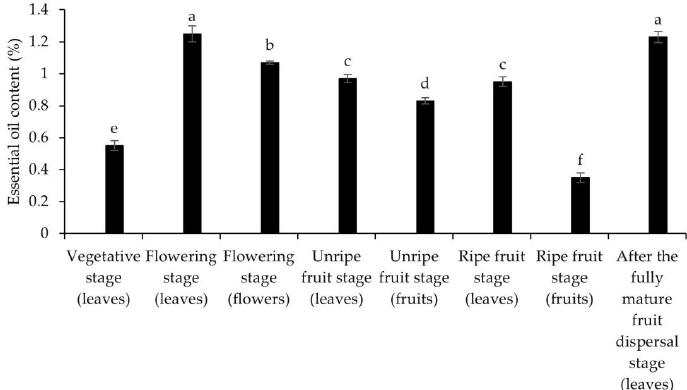
Figure 2. Changes in essential oil content (% w / w ) of myrtle organs in different phenological stages. Essential oil contents with different subscript were significantly different at p < 0.05 (Duncan